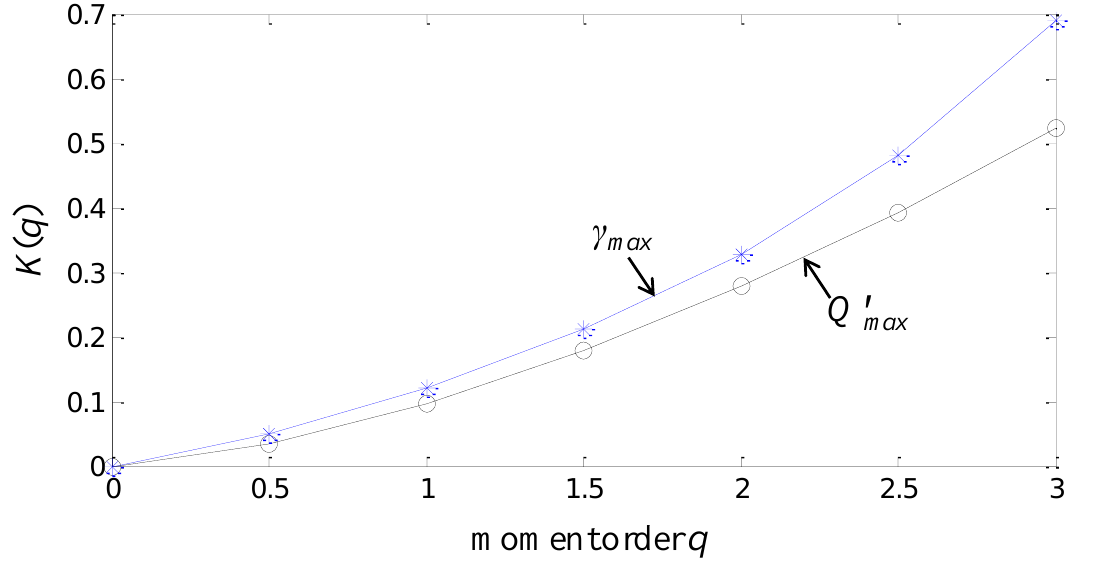
Figure 5. Empirical moment scaling functions K ( q ) for the standardized discharge maxima Q (cid:48) max = Q max / A (circles), and the amplification factor γ max = Q max / E [ Q ] (stars).